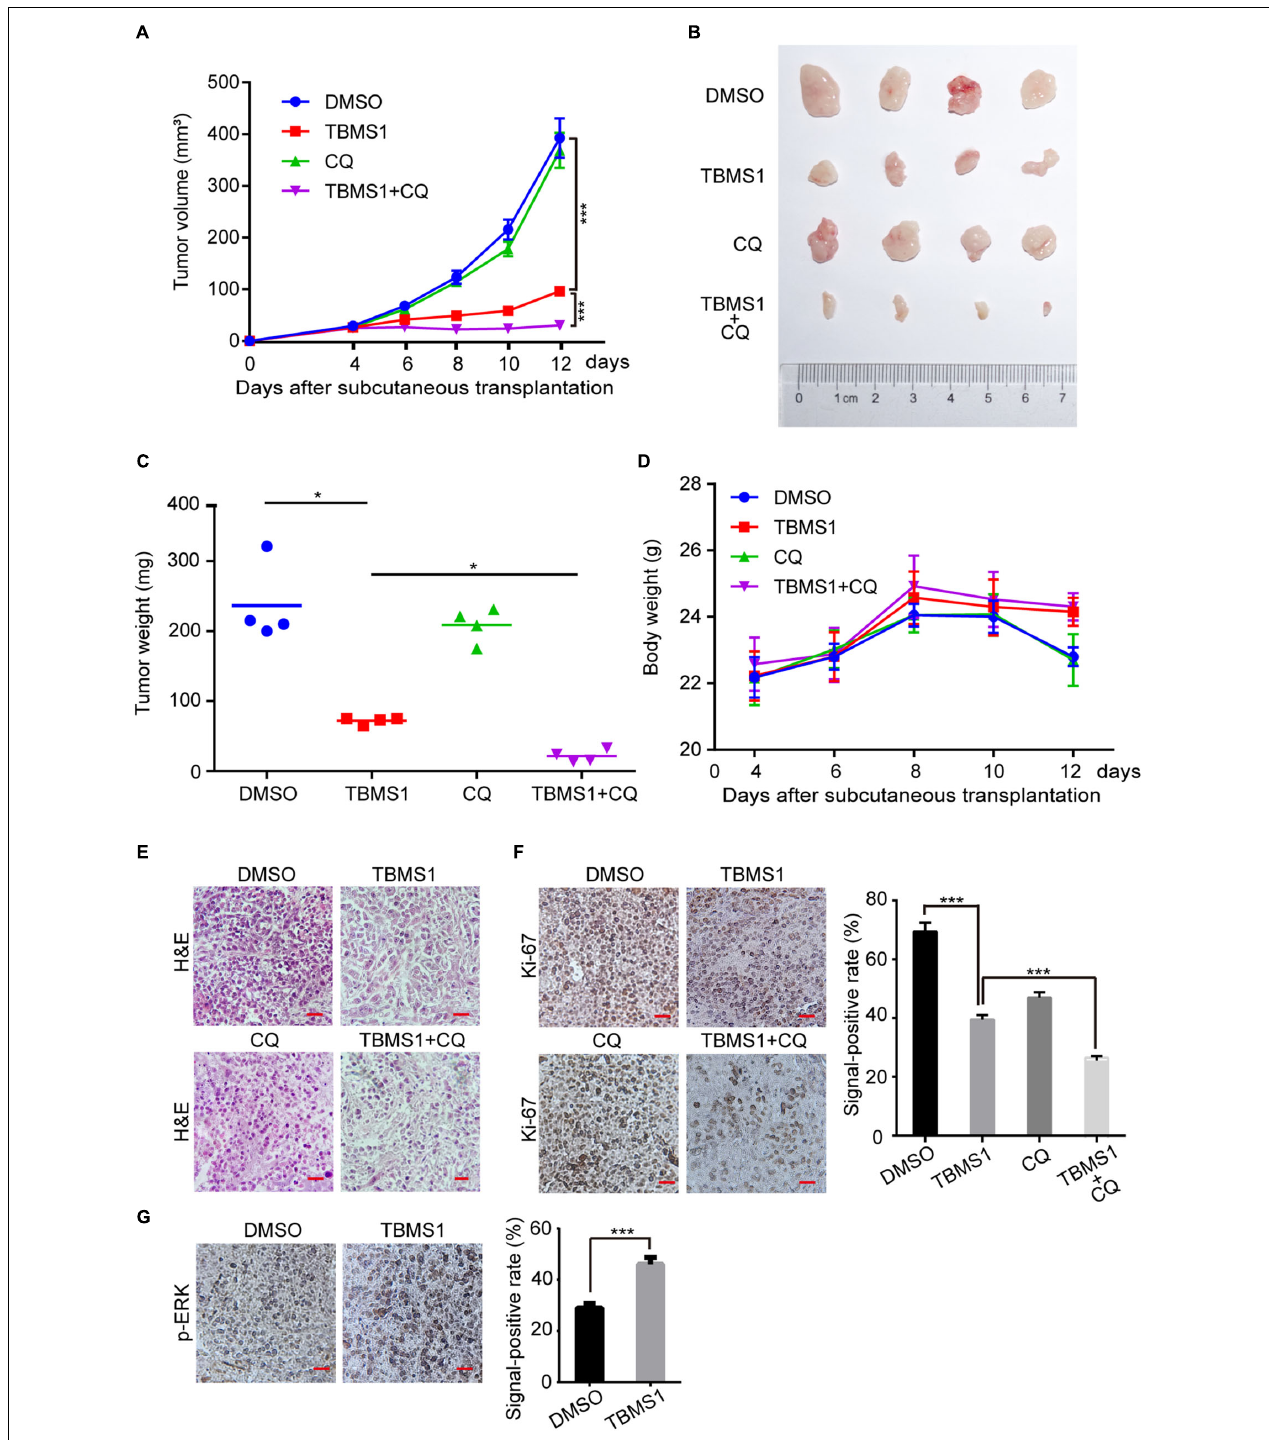
FIGURE 6 | TBMS1 suppresses melanoma cell tumorigenecity in vivo . (A) The capacity of tumorigenicity was tested in nude mice subcutaneous injected with MV3 cells. After 4 days, mice were treated with TBMS1 (3 mg/kg/day, diluted into saline with 5% DMSO), CQ (50 mg/kg/day, diluted into saline with 5% DMSO), combination with two drugs or control solvent by intraperitoneal. Tumor volume was measured every 2 from 4 days after subcutaneous injection. (B) Tumors after resection. (C) Tumor weight was detected after the tumor resection. (D) The body weight of mice was measured every 2 from 4 days after subcutaneous injection. (E) H&E staining of xenografts obtained from subcutaneous injection of MV3 cells under control, TBMS1, CQ or combination treatment. (F,G) IHC staining of Ki-67 and p-ERK in xenografts obtained from subcutaneous injection of MV3 cells under control, TBMS1, CQ, or combination treatment. Signal-positive rate was analyzed through IHC profiler in the Image J software. A two-tailed unpaired Student’s t -test was carried out. * p < 0.05, ** p < 0.01, *** p < 0.001, **** p < 0.0001.